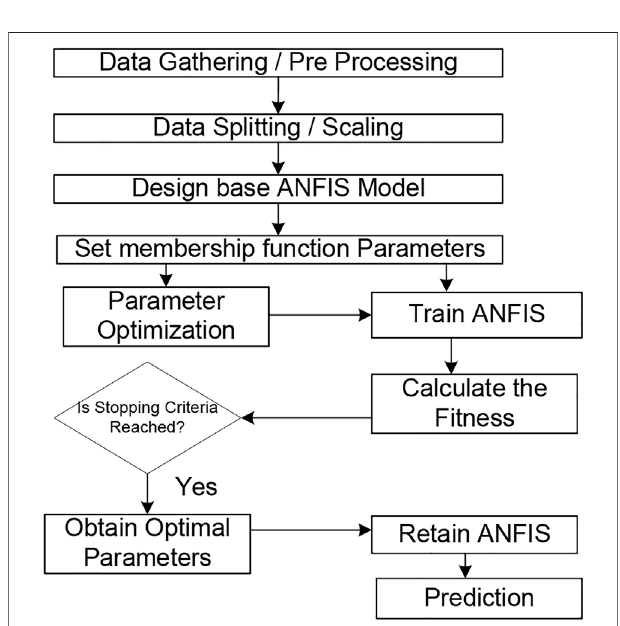
FIGURE 3 | Data fl ow and processing of the ANFIS